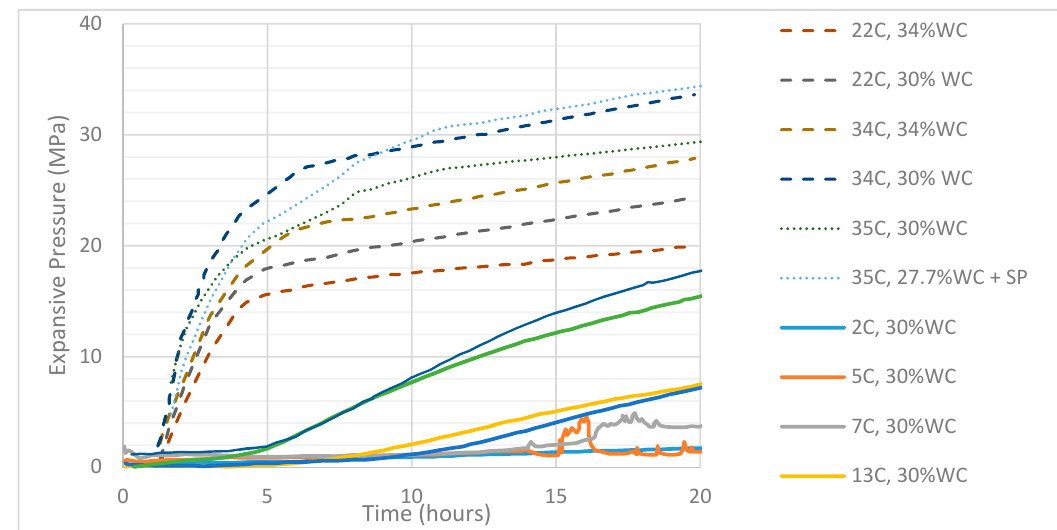
Figure 2. Variation of expansive pressure of SCDA with moisture content and ambient temperature [38,40,61].